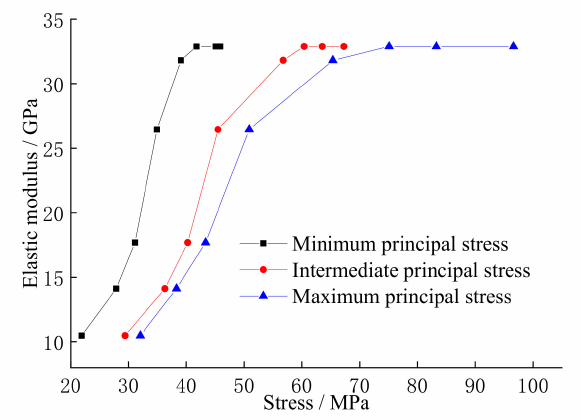
Figure 11. Relationship between the major principal stress and elastic modulus.